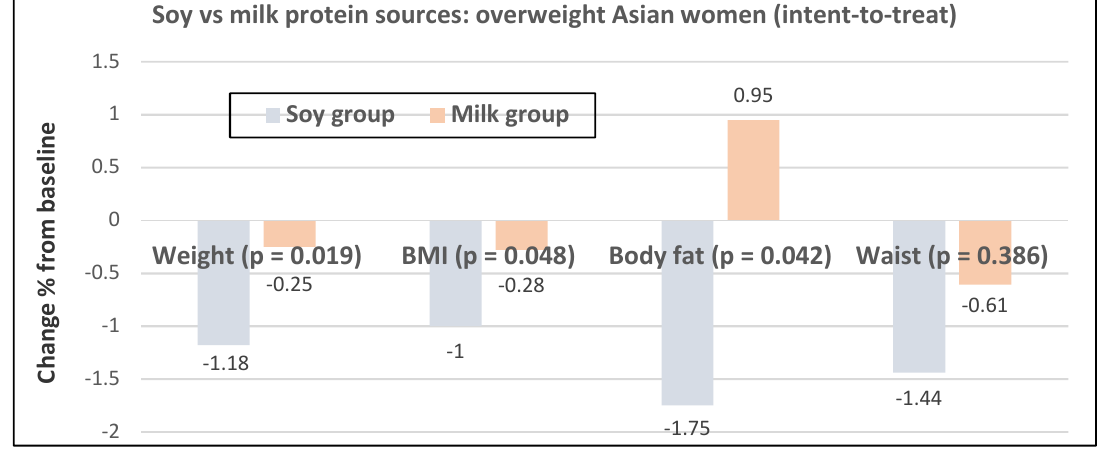
Figure 24. Multivariate % change in anthropometric measures in 180 overweight Chinese women consuming 15-g soy protein vs. milk protein for six months in a double-blind RCT [67].